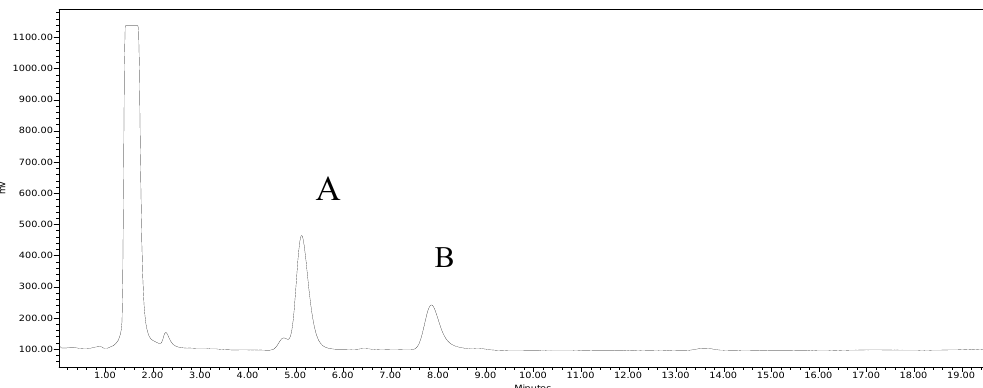
Figure 4. A representative HPLC chromatogram of Joe Parker showing baseline separation of capsaicin ( A ) and dihydro- capsaicin ( B ).